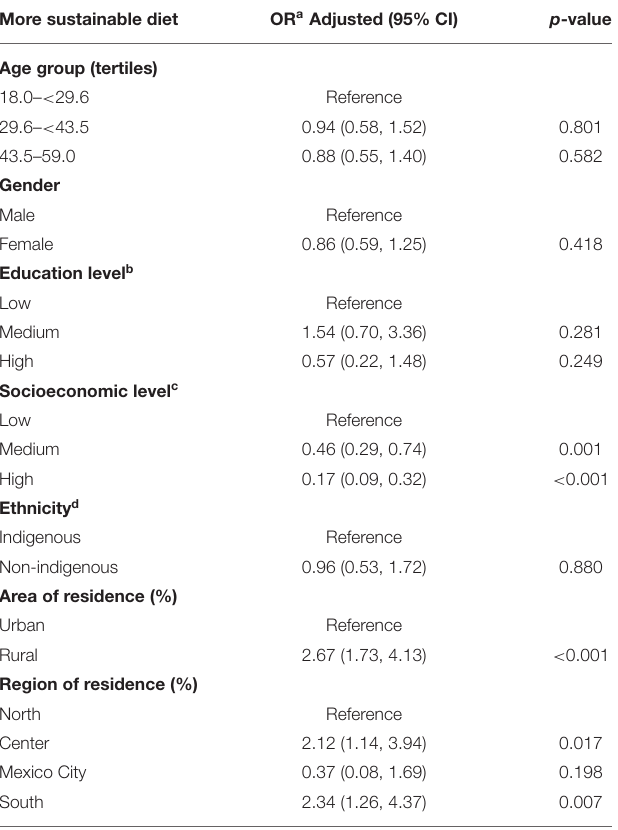
TABLE 3 | Sociodemographic characteristics associated with consumption of more sustainable diets (MSD) in Mexico. More sustainable